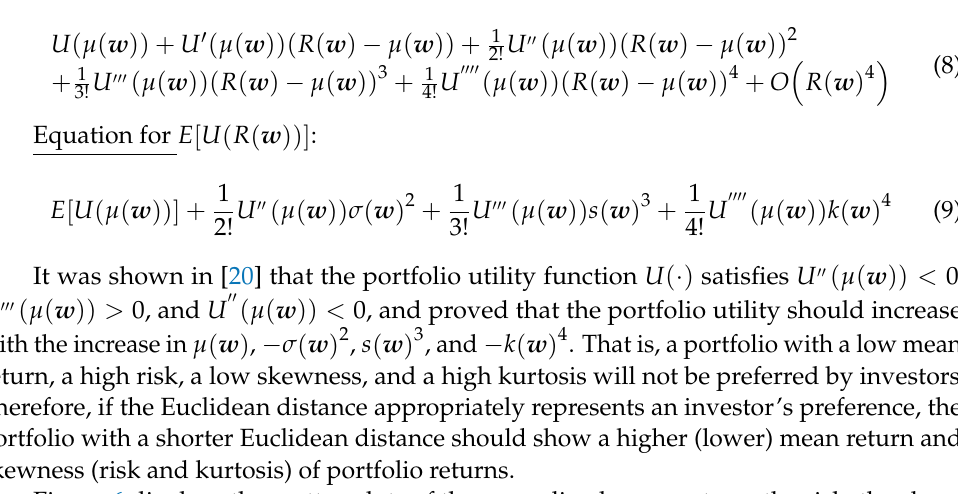
Figure 6. Moments of return according to the Euclidean distance. ( a ) rate of return; ( b ) risk; ( c ) skewness; ( d ) kurtosis. 5.2. Risk-Return Analysis of Portfolio Based on the Euclidean Distance Recall that, in Section 4.2, we confirmed that the Euclidean distance showed a mon- otone (and therefore consistent) relationship with the mean portfolio return and the risk. We now further investigate, in addition to these monotone relationships, how the mean return and the risk change with the Euclidean distance. We categorize the 30,000 random portfolios into 10 groups based on the Euclidean distance and draw the risk-return scatter diagram of each group. For example, 3000 port- folios with the shortest Euclidean distance are classified as Group 1, and 3000 portfolios with the longest Euclidean distance as Group 10. The risk-return scatter diagrams for all 10 groups are shown in Figure 7. The horizontal axis is the risk, and the vertical axis is the excess mean return over the risk-free rate. Descriptive statistics for each group are sum- marized in Table 6.